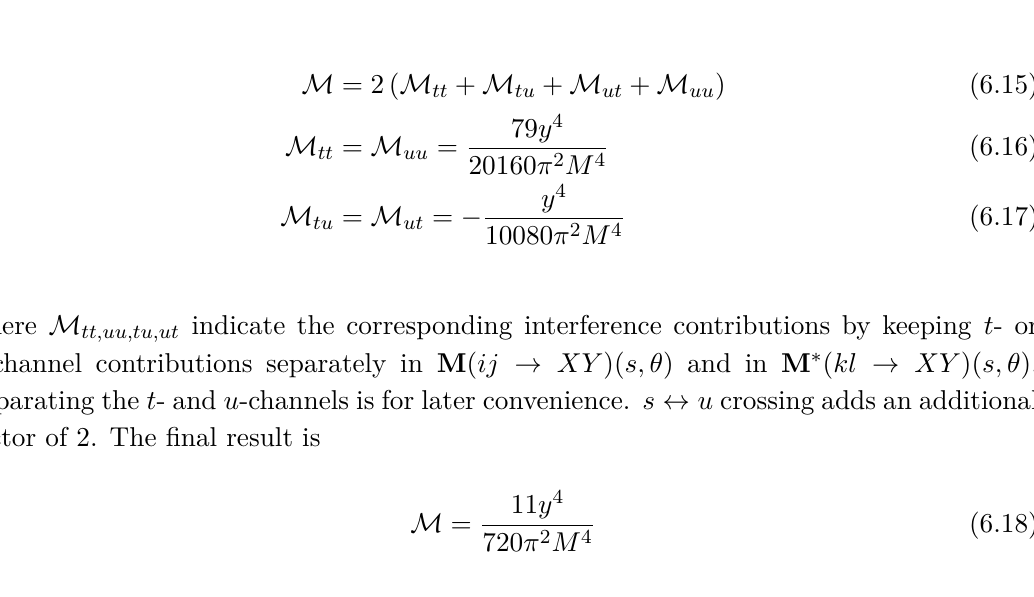
Figure 17. Diagrams for HH † , H † H → F 1 diagram. The arrow represents the SU(2) charge flow. Double lines represent heavy